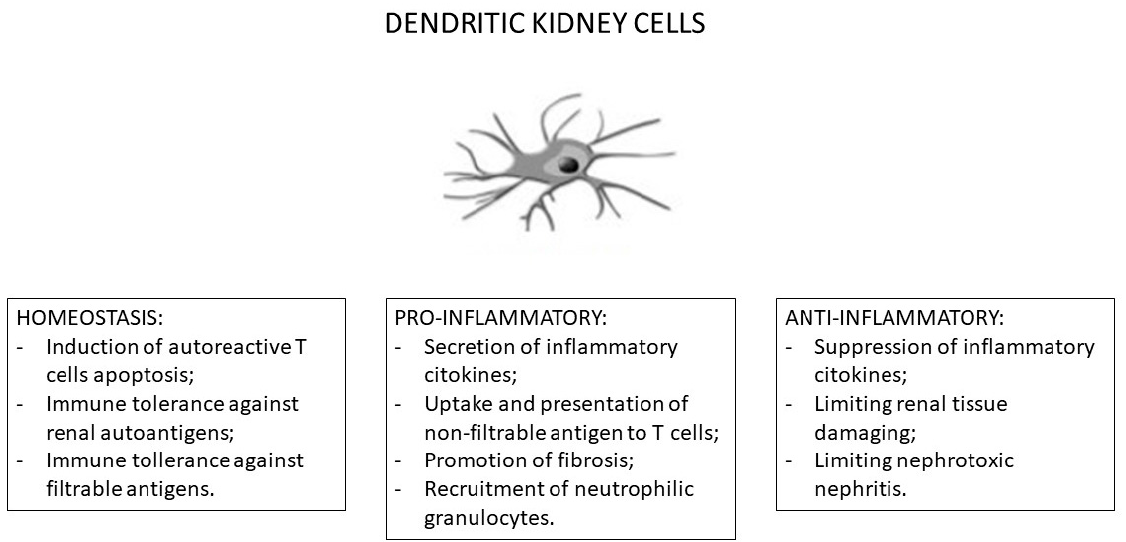
Figure 3. Renal DCs properties and main activity.